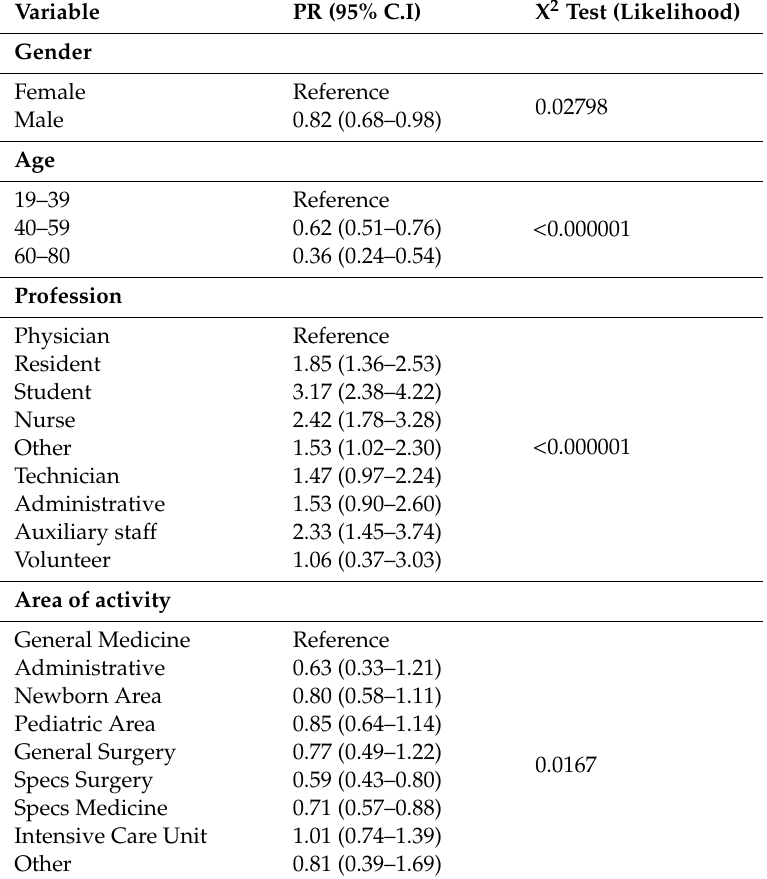
Table 5. Prevalence ratios of never vaccinated before versus vaccinated before (year